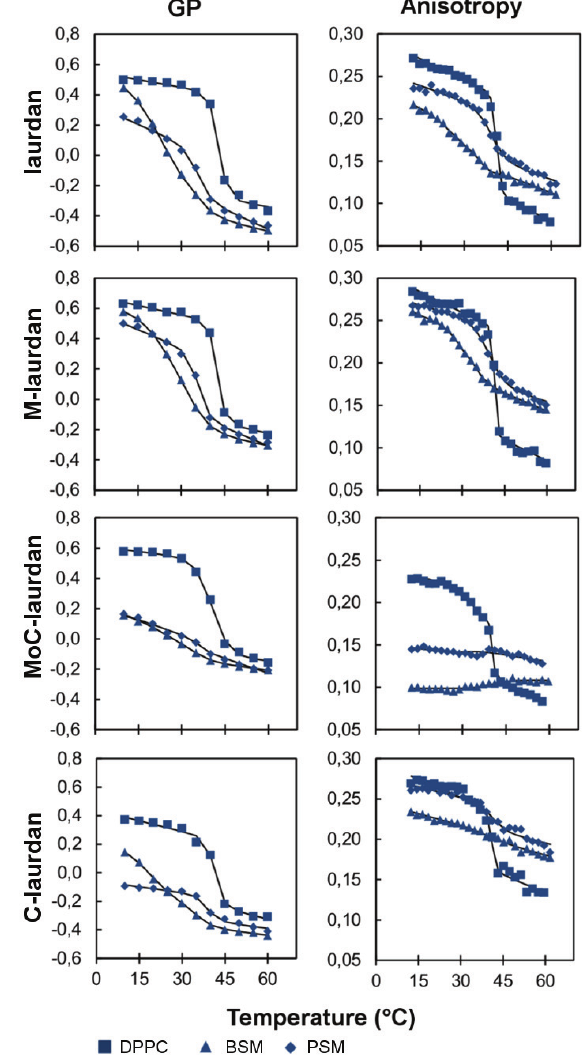
Figure 5. GP and anisotropy of laurdan, M-laurdan, MoC-laurdan and C-laurdan dyes in model membrane undergoing So to Ld transition (blue color code depicting solid ordered phases at low